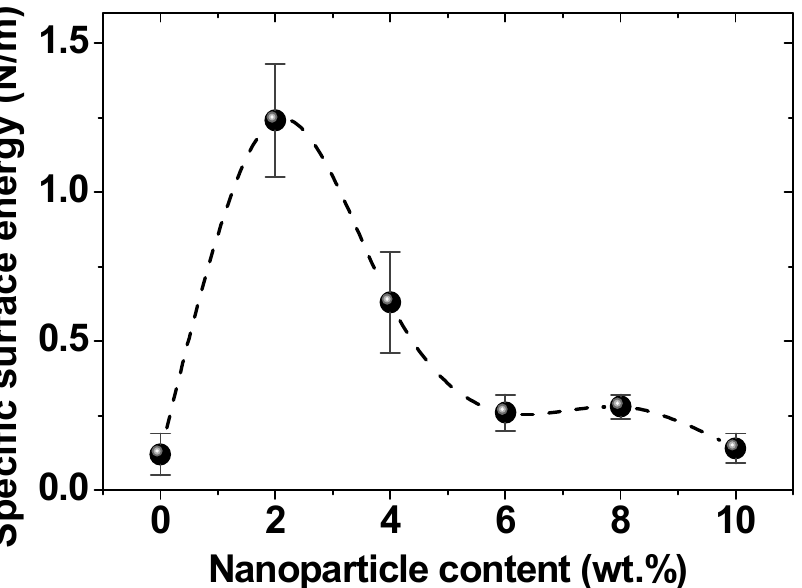
Figure 9. The specific surface energy of “MZFA/PVA” nanocomposites.